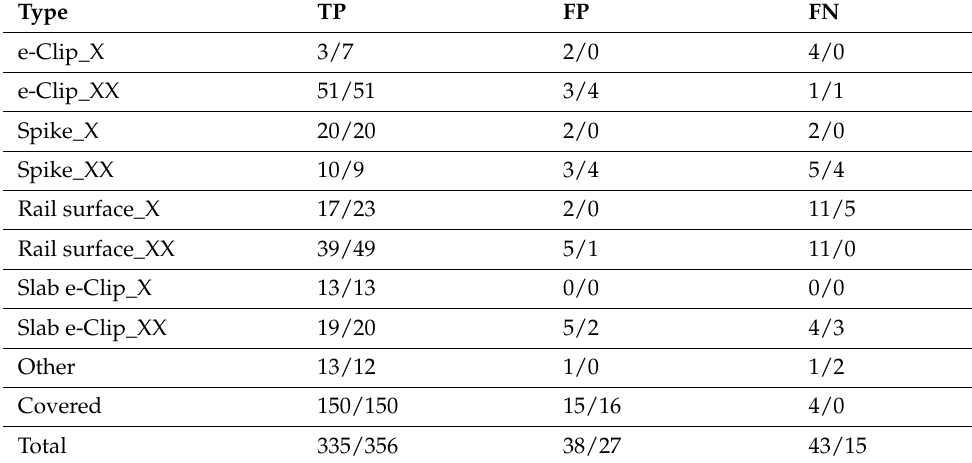
Table 16. SSD 512/300 training results of the top